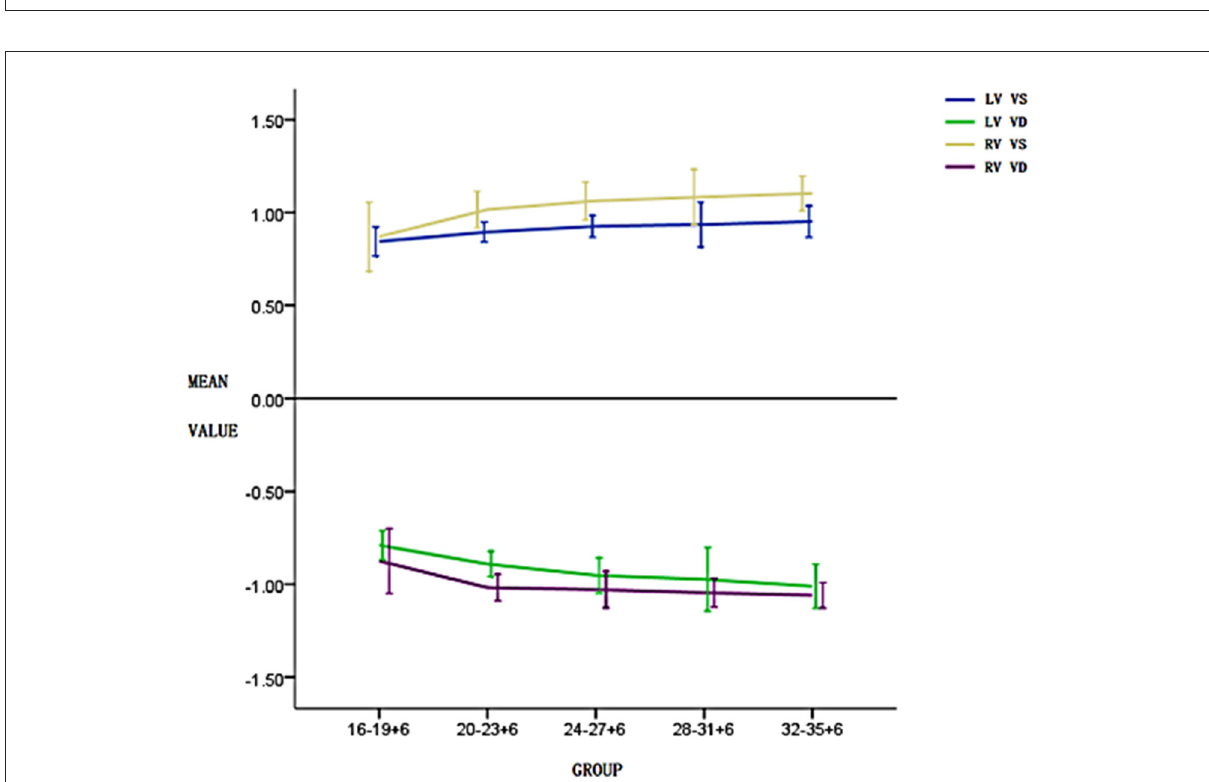
FIGURE2 Changes in the left and right ventricular systolic and diastolic global peak velocities in five pregnancy groups. The global peak velocity gradually increases with the increase in gestational weeks and the global peak velocity of the right ventricle in both systolic and diastolic phases is higher than that of the left